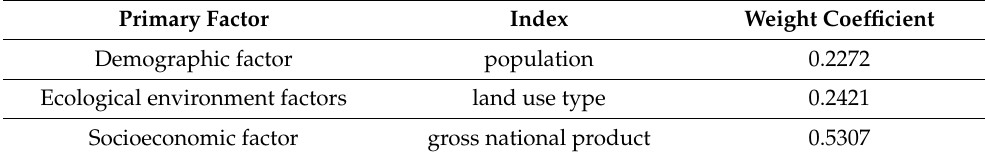
Table 5. Exposure evaluation index system and weight coefficient of disaster-bearing body.